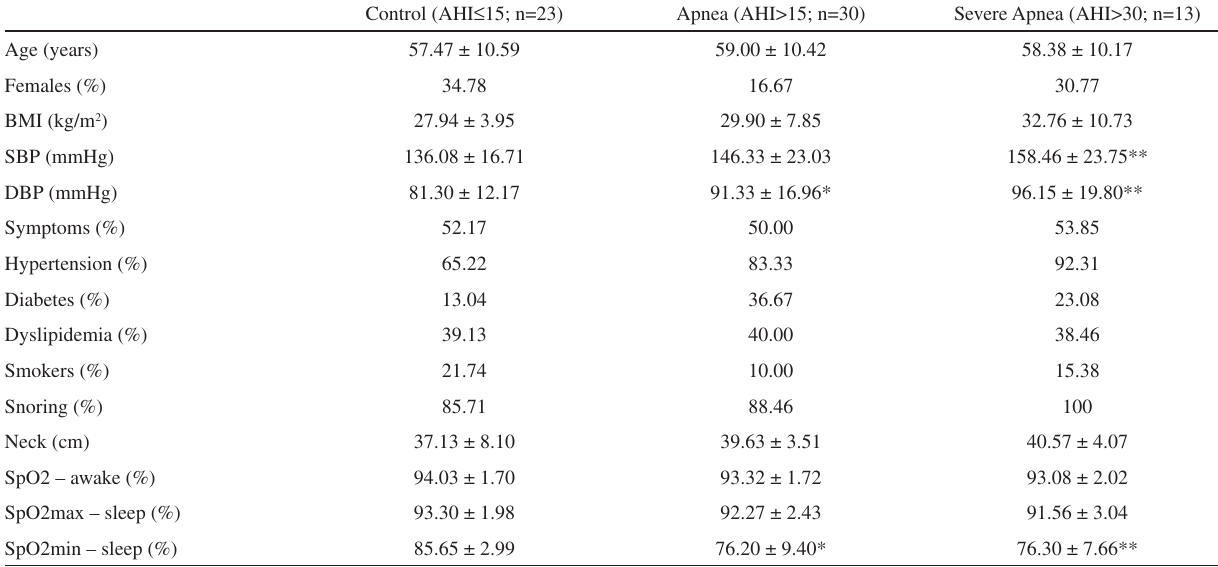
Table 1 - Baseline clinical